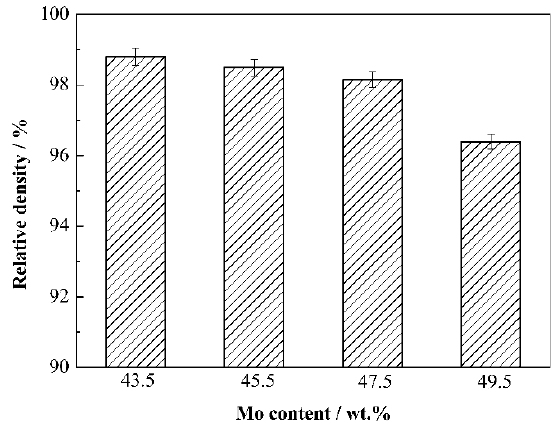
Figure 8. Relative density of Mo 2 FeB 2 -based cermets with different Mo contents.